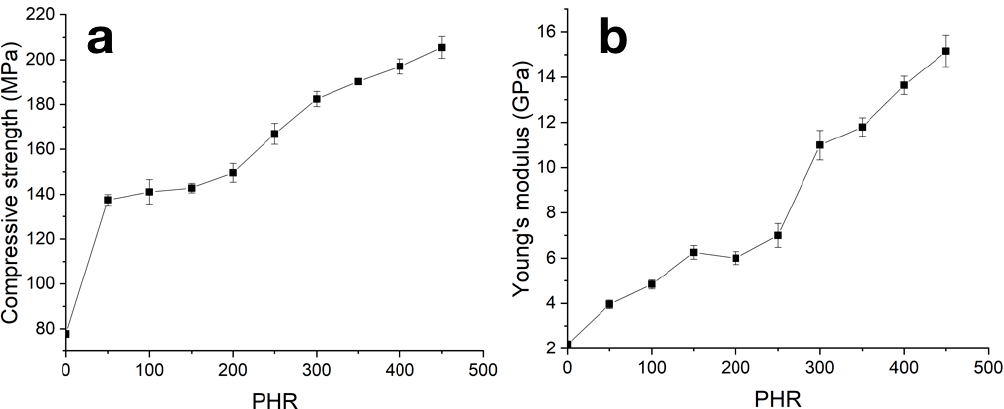
Figure 8. Concentration dependencies of strength ( a ) and Young modulus ( b ) from compression tests of carbonized samples.